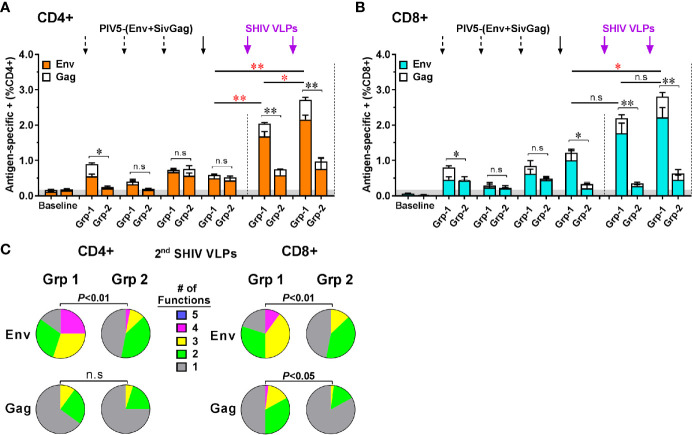
Characterization of vaccine-induced antigen-specific CD4+ and CD8+ memory T cells responses by intracellular cytokine staining for cells secreting IFN-γ, TNF-α, IL-17A, MIP-1β, and CD107a. Stacked responses to HIV Env and SIV Gag peptides pool by (A) CD4+ and (B) CD8+ cells between Group 1 (Grp-1) and Group 2 (Grp-2). Three black dashed arrows mark PIV5-(Env+SivGag) primes with different doses (IN) and one black solid arrow marks the fourth prime. Purple solid arrows mark the SHIV VLPs boosts (IM). The statistical differences were examined between the last prime and first and 2nd VLPs boost and illustrated the significant p value as red asterisks. (C) Env- and Gag-specific CD4+ and CD8+ T cells polyfunctional responses between two groups. Pie charts represent the distribution of cytokine profile with mono-(grey), bi-(green), tri-(yellow), tetra-(pink), or penta-(blue) combinatorial functions. Analyses were performed with the Pestle and SPICE software. Student’s t-test and permutation test were used for pie comparison between two groups. The level of significance is indicated by P-values as follows: *P < 0.05; **P < 0.01. n.s, P > 0.05, not significant.